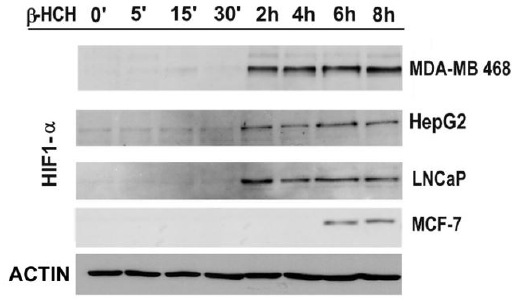
Figure 6. The expression levels of HIF ‐ 1 α were detected by immunoblot analysis in a time ‐ course experiment performed on MDA ‐ MB 468, HepG2, LNCaP, and MCF ‐ 7 cells treated with β‐ HCH (10 μ M). Actin was used as normalization protein.